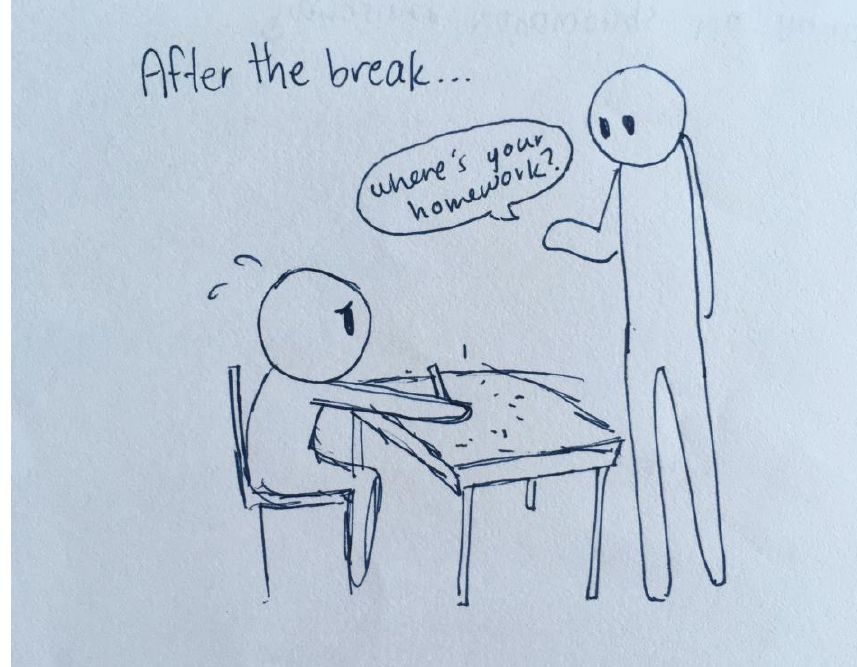
Figure 1. Increased academic demands were a primary stressor of the middle school to high school